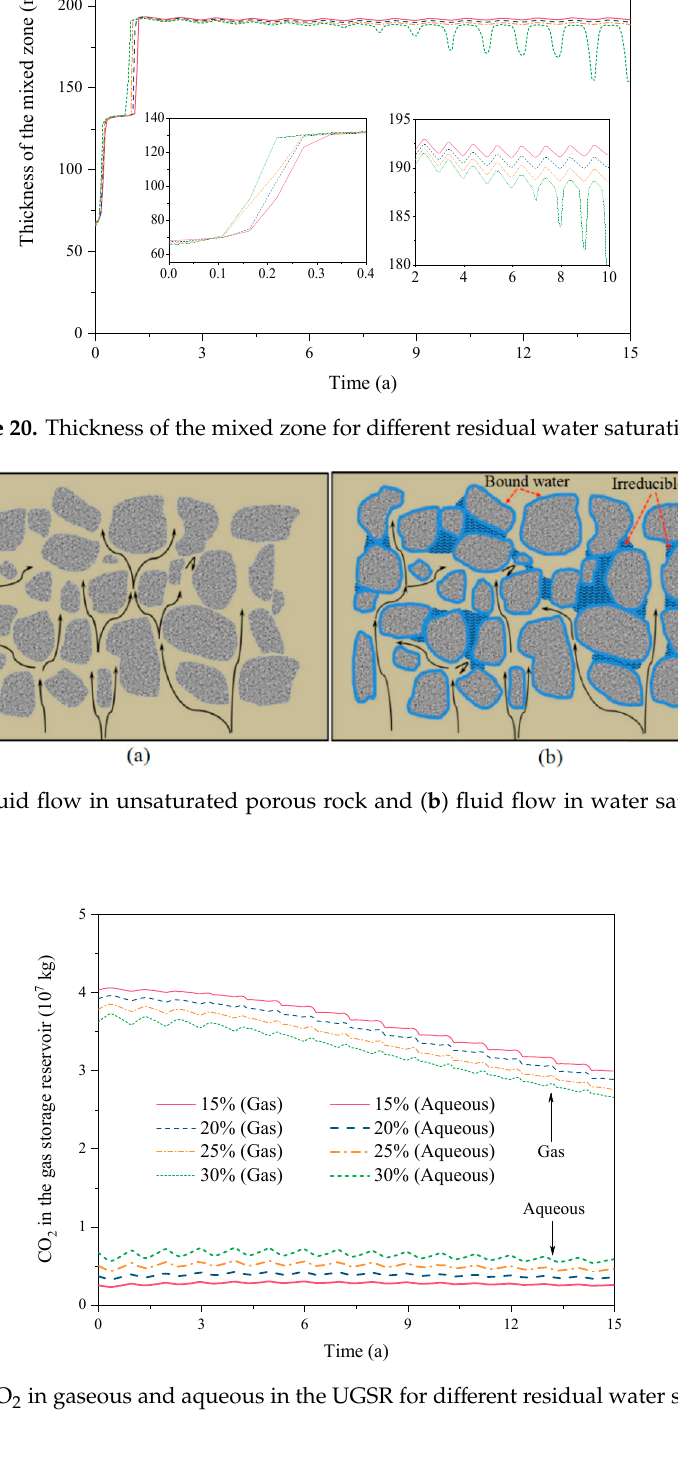
Figure 22. CO 2 in gaseous and aqueous in the UGSR for different residual water saturations.